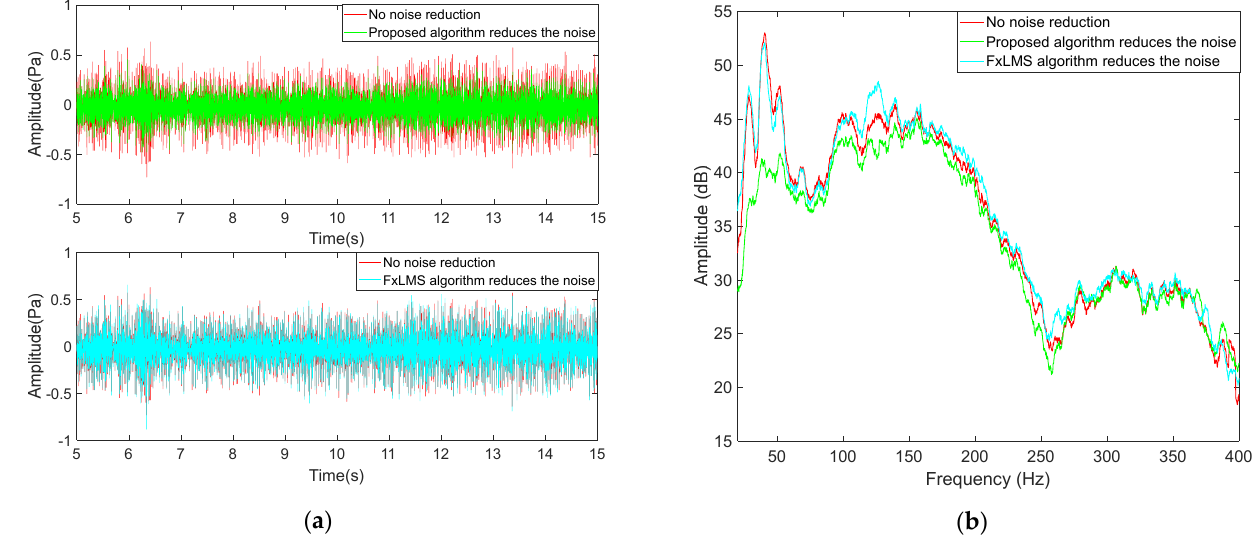
Figure 17. Experimental noise reduction effect of a 60 km/h constant driving speed. ( a ) The time domain, ( b ) The frequency domain.